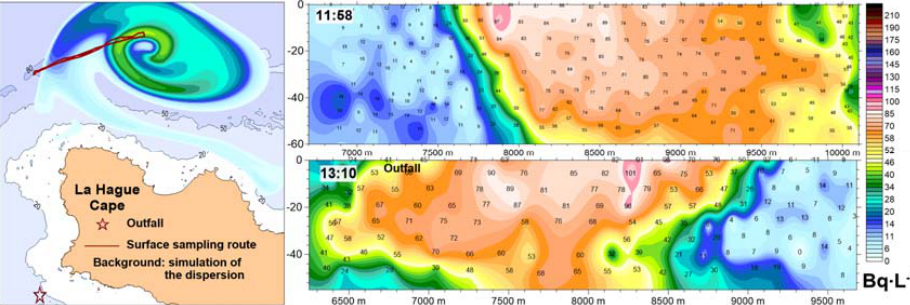
Figure 8. Vertical concentrations of the plume five and six hours after a release and at 7 km distance. Left: distribution of surface sampling locations during the survey the 6 April 2011 (red dots).